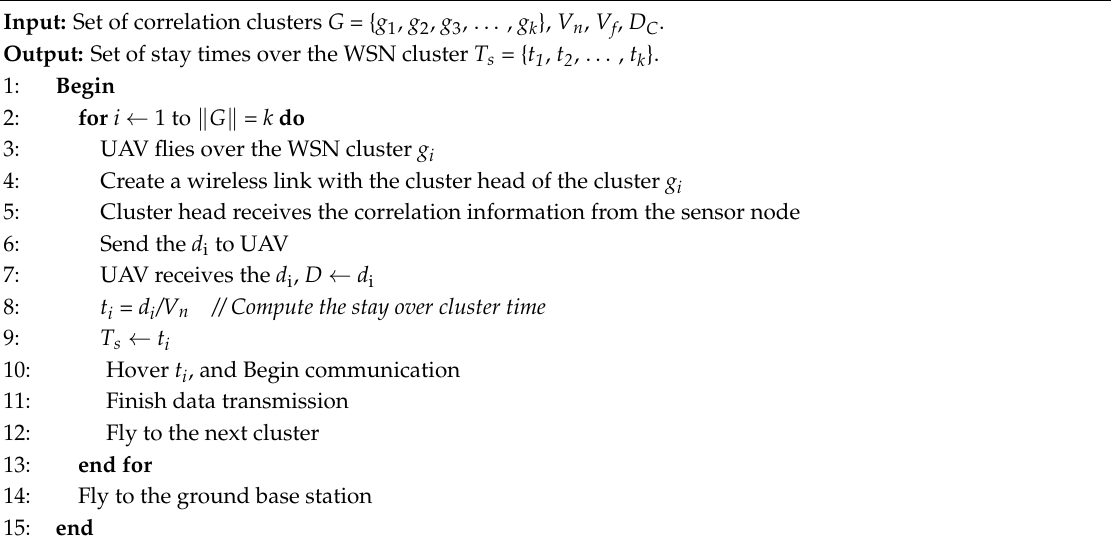
Algorithm 2. Compute the dynamic flying parameters and parameters for data